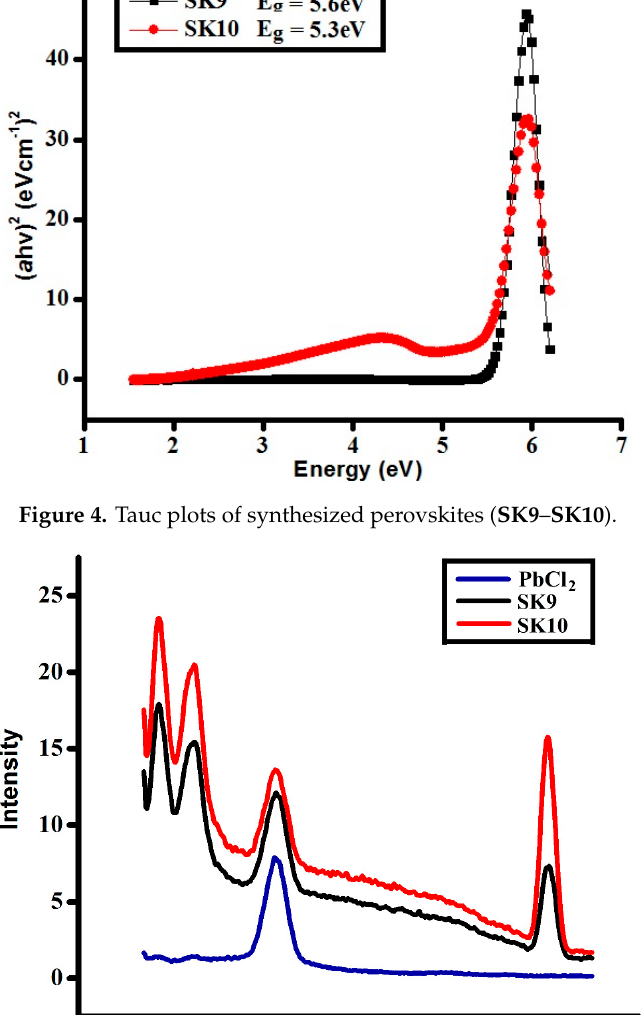
Figure 3. UV spectra of synthesized perovskites ( SK9 – SK10 ) and PbCl 2.